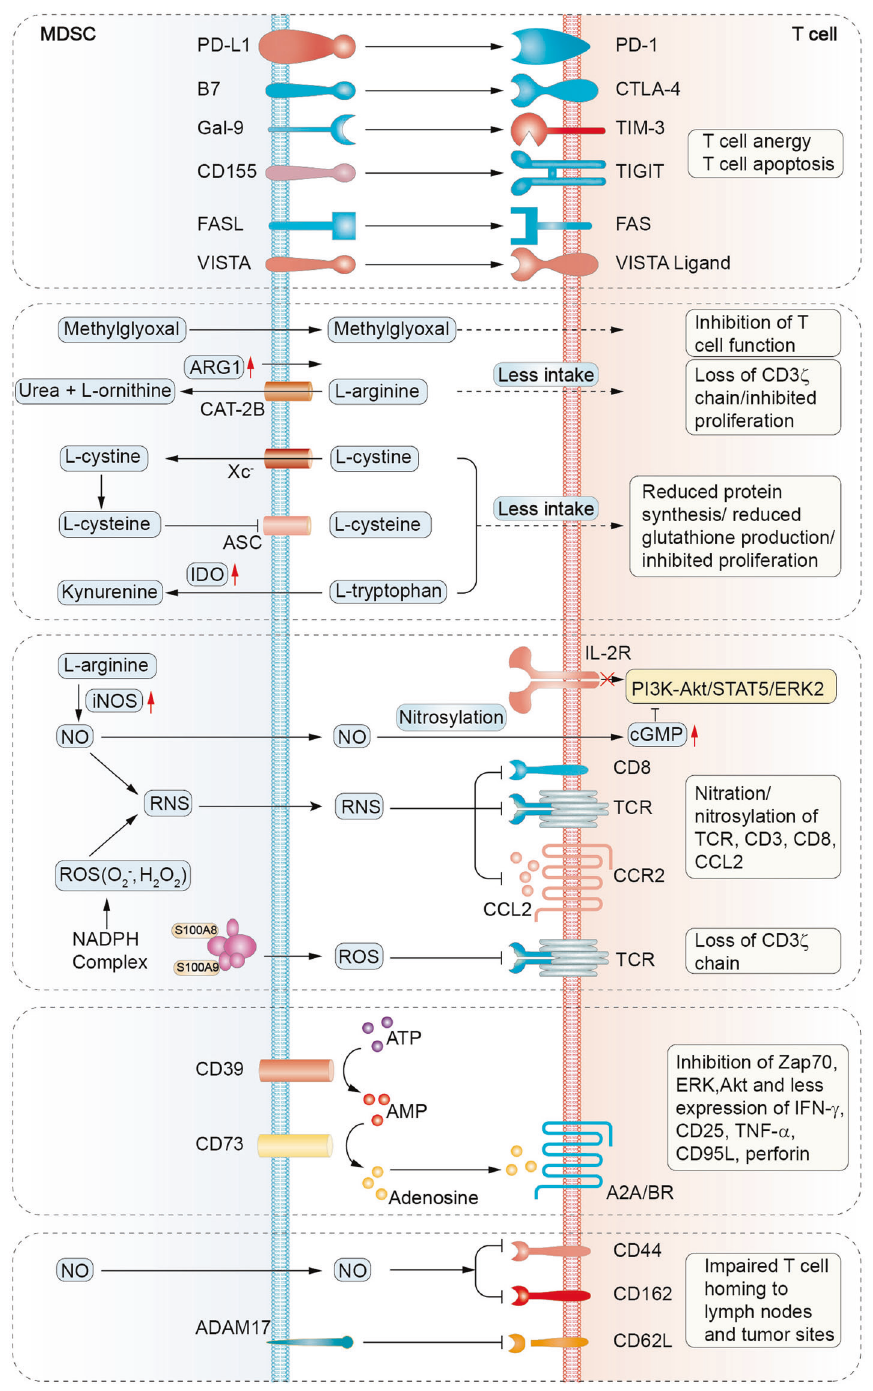
Fig. 4 Mechanisms of MDSCs-mediated T cells suppression. MDSCs suppress T cell activity through distinct mechanisms including expression of negative immune checkpoint molecules, depletion of amino acids necessary for T cell response, production of NO, ROS, RNS, generation of adenosines, and impairment of T cell homing to peripheral lymph nodes and tumor sites. TIM-3, T cell immunoglobulin and mucin domain-3; Gal-9, galectin-9; TIGIT, T cell immunoglobulin and ITIM domain; VISTA, V-domain Ig-containing suppressor of T-cell activation; CAT-2B, cationic amino acid transporter 2B; ASC, asctype amino acid transporter; Xc – , cystine – glutamate transporter; IDO, indole-2,3 dioxygenase; iNOS, inducible nitric oxide synthase; NO, nitric oxide; TCR, T cell receptor; Zap70, zeta-associated protein 70; ERK, extracellular-signal-regulated kinase; Akt, protein kinase B; ADAM17, a disintegrin and metalloproteinase domain Crosstalk between MDSCs and other immune cells . Apart from CD162 on T cells by M-MDSCs-derived NO can damage T cells T cells, MDSCs also deliver immune inhibition on other tumoricidal extravasation and tissue in fi ltration. 112 In addition, NO was also immune cells such as NK cells, DCs, and B cells. It was reported reported to decrease E-selectin expression on tumor vessels, that membrane-bound TGF- β 1 on MDSCs contributed to thereby inhibiting T cells traf fi cking to tumor tissues. 113